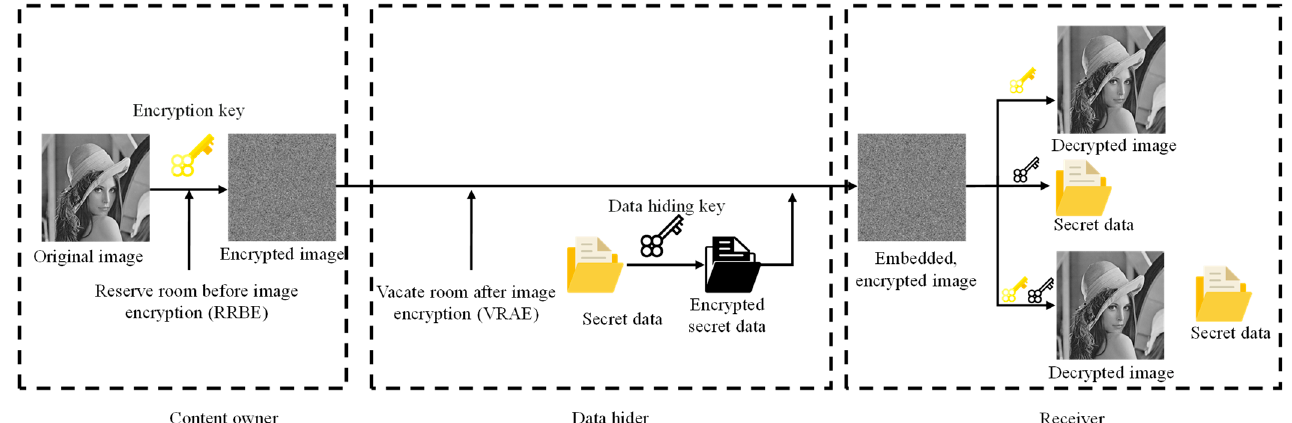
Figure 1. The overall process of RDHEI.